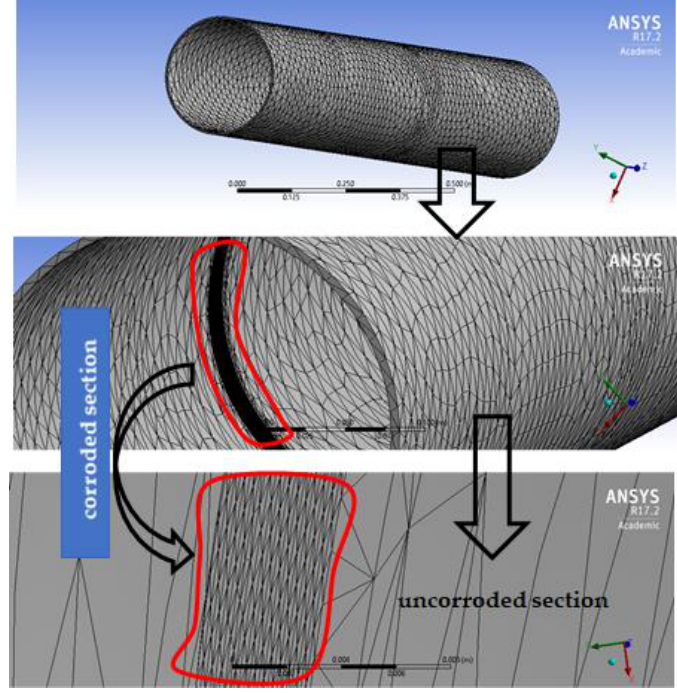
Figure 3. Nonlinear FEM for X52 grade pipe of 273.05 mm diameter, 5.23 mm thick, d/t of 0.1 and L of 105 mm.